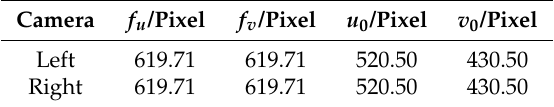
Table 2. The intrinsic parameters of the left and right simulated